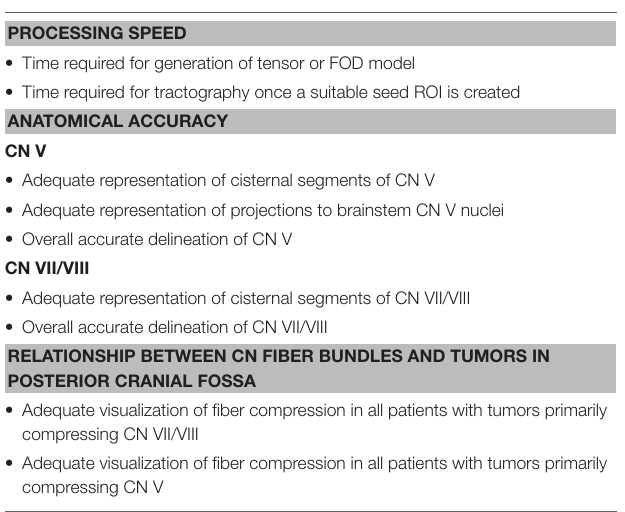
TABLE 3 | Criteria for assessing the results obtained from the three discrete tractography methodologies. PROCESSING